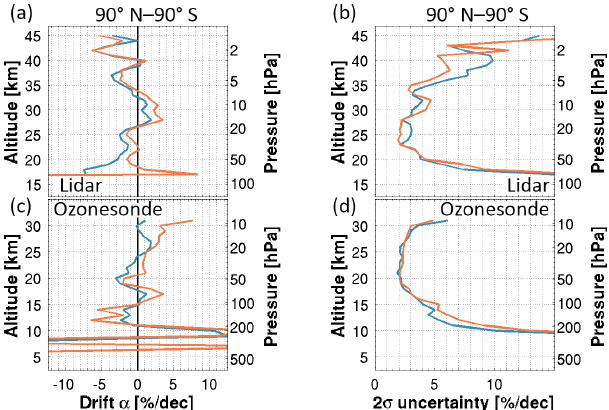
Figure 10. (a, c) Network-averaged drift of the old (blue) and the new (orange) MIPAS ozone versus lidar (a, b) and ozonesonde (c, d) measurements for 2005–2012 period profiles. (b, d) 2 σ uncer- tainty of estimated